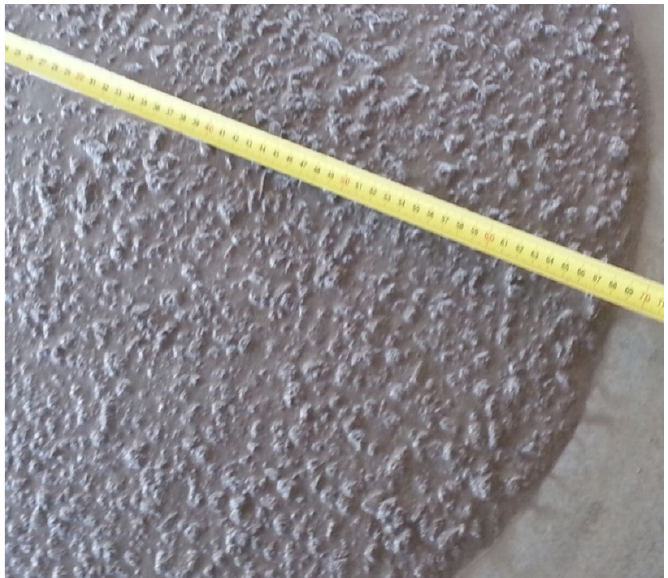
Figure 3. Focus on the end of the SCC in the slump flow